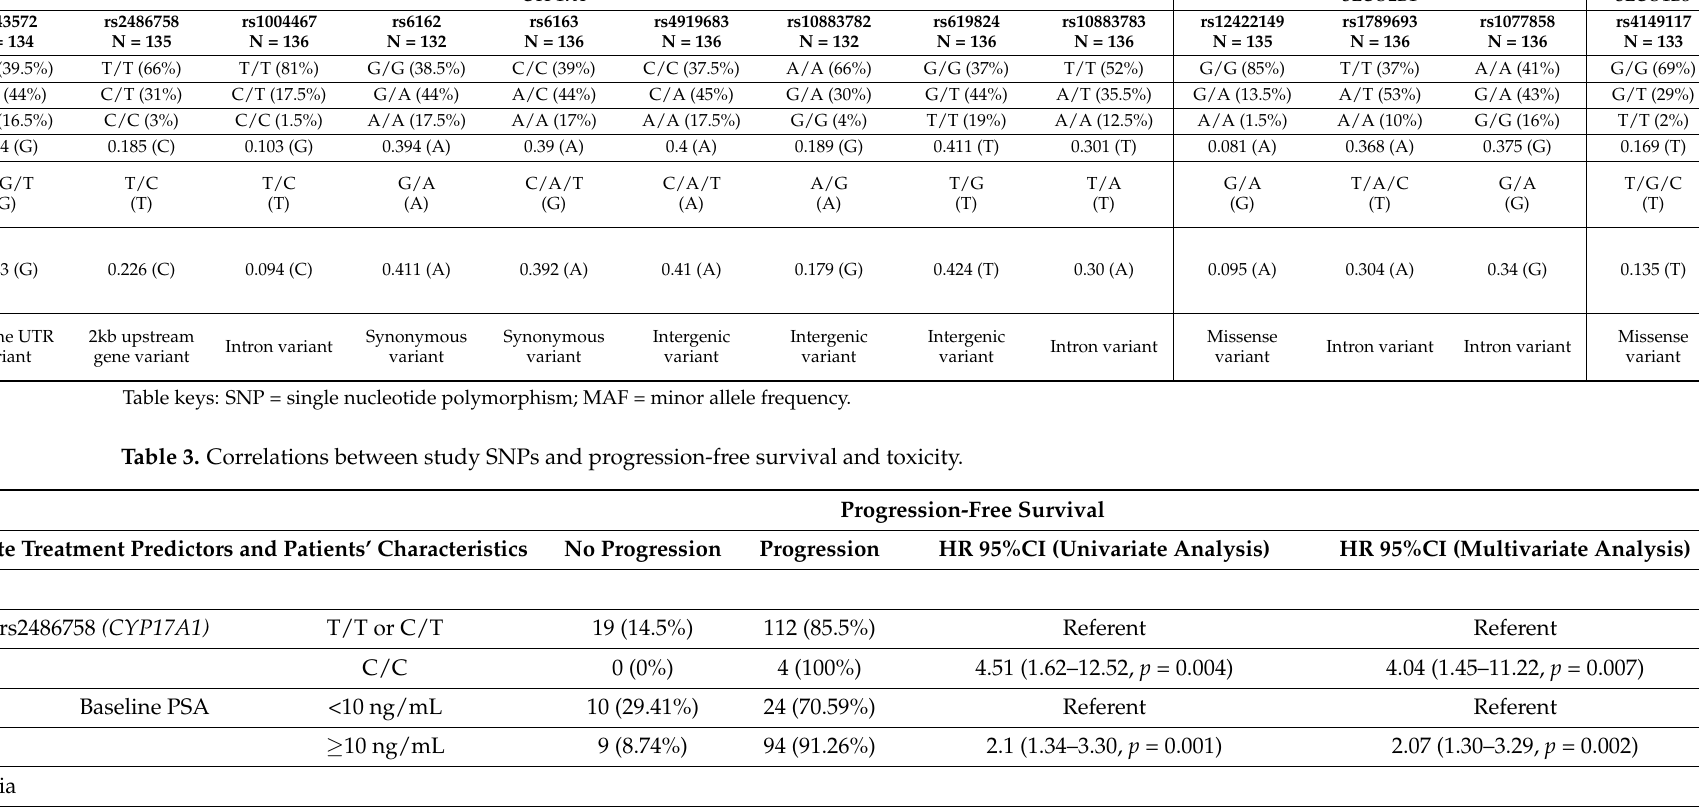
Table 2. Summary of genotyping data for the study patients (N = 137).